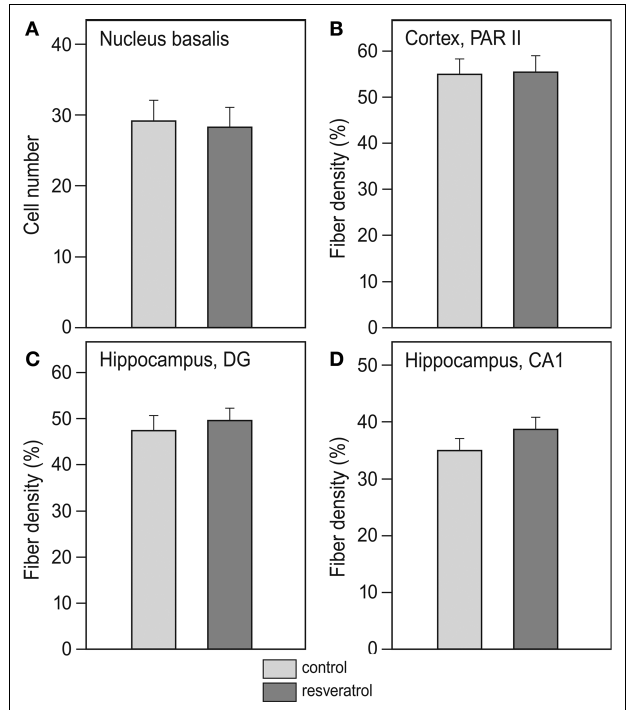
FIGURE 3 | Effects of chronic resveratrol supplementation on the cholinergic system. (A) Average cholinergic cell number per section in the nucleus basalis is unchanged in the resveratrol-treated animals ( n = 11) versus control-treated animals ( n = 11). (B) Cholinergic fi ber density in hippocampal CA1 and (C) dentate gyrus show no effect of resveratrol treatment. (D) Cholinergic fi ber density in the parietal cortex (PARII) does not show an effect of resveratrol treatment.